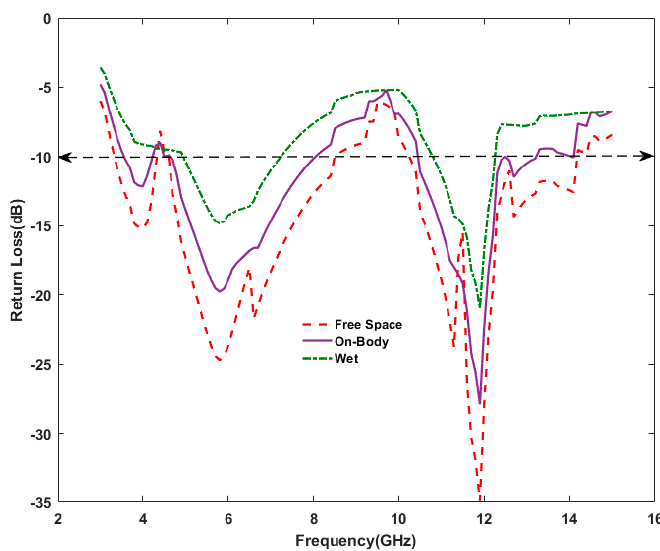
Figure 16. Measured performance of antenna in different conditions.